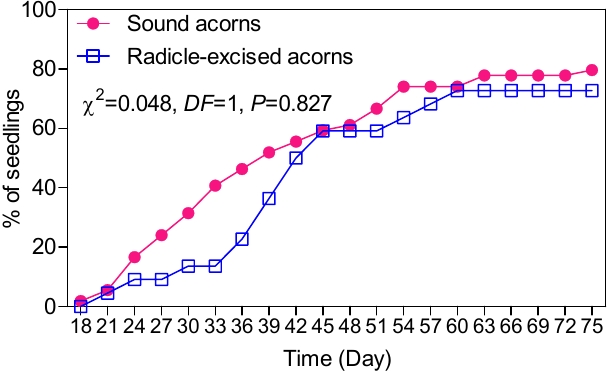
Figure 3. Seedling emerging dynamics of sound and radicle ‐ excised acorn s (ULRS).